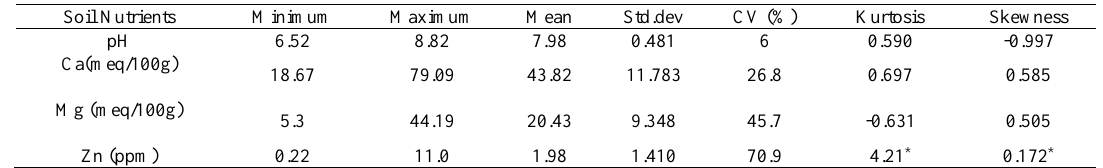
Table 2. Soil nutrients descriptive statistics